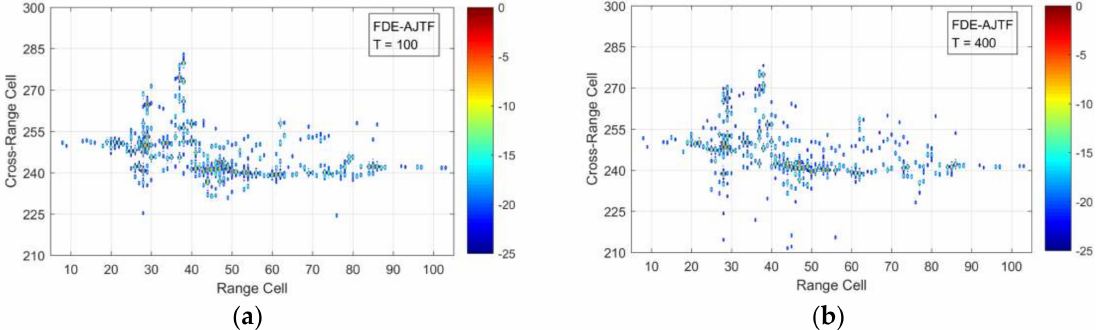
Figure 11. Imaging results using FDE–AJTF. ( a ) T = 100; and ( b ) T =